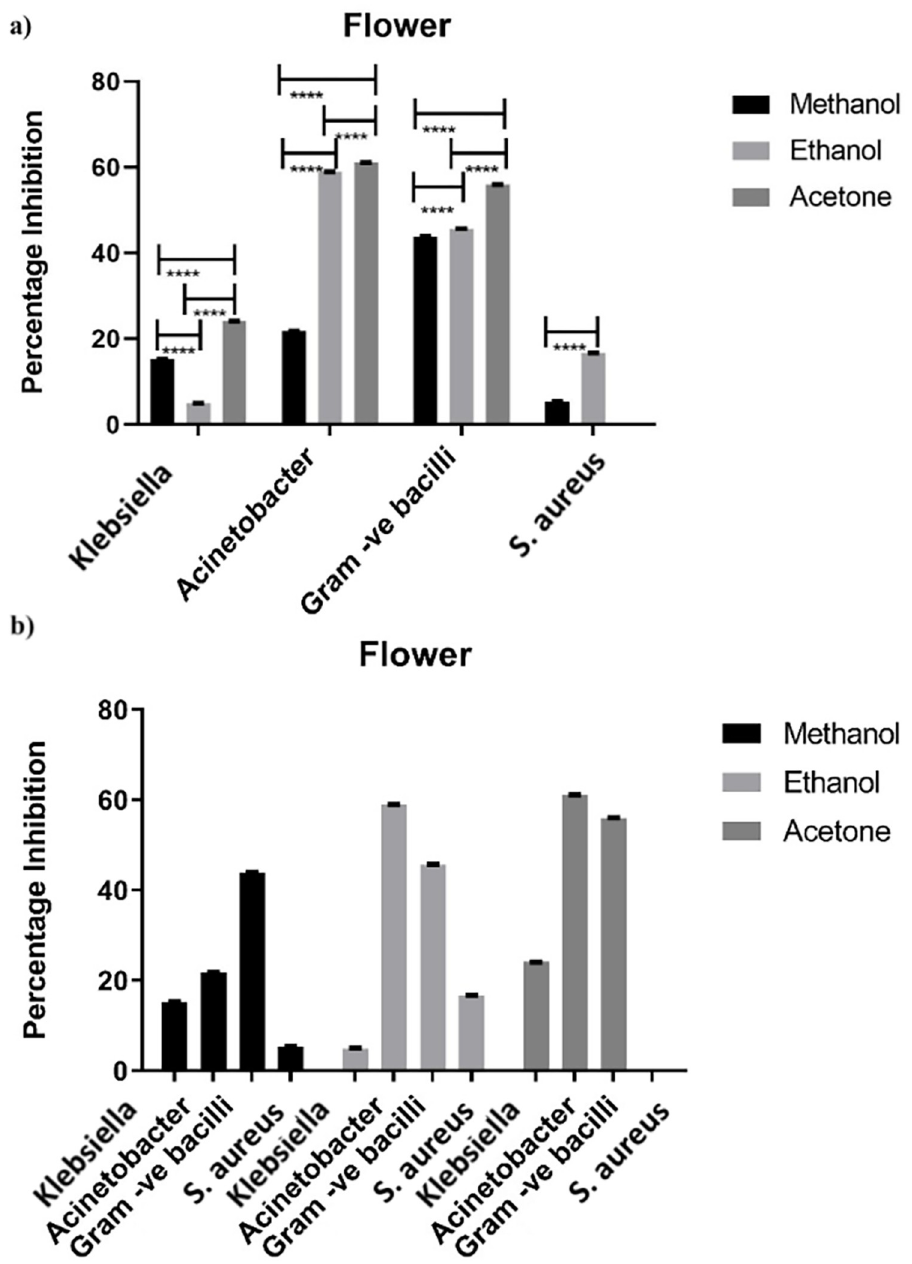
Fig 2. Statistical comparison of antimicrobial activity of flower against various bacteria. (a) Effect of each solvent on individual bacterium. (b) Comparison of each solvent with all selected bacterial spp. Bar represents ± SEM. Data was analyzed by two-way analysis of variance (ANOVA) (P < 0.001). * = significant, ns =